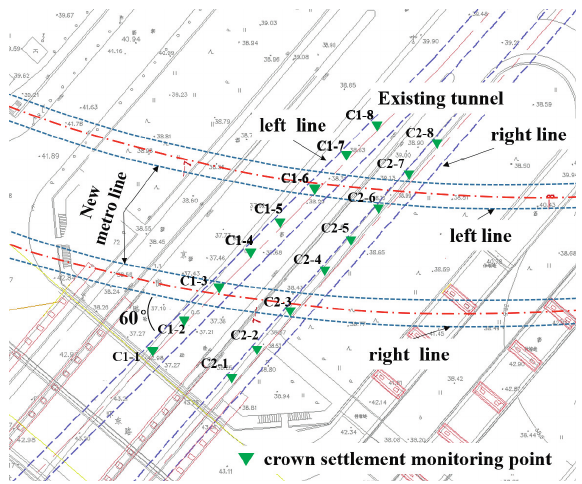
Figure 3: Plan view of undercrossing